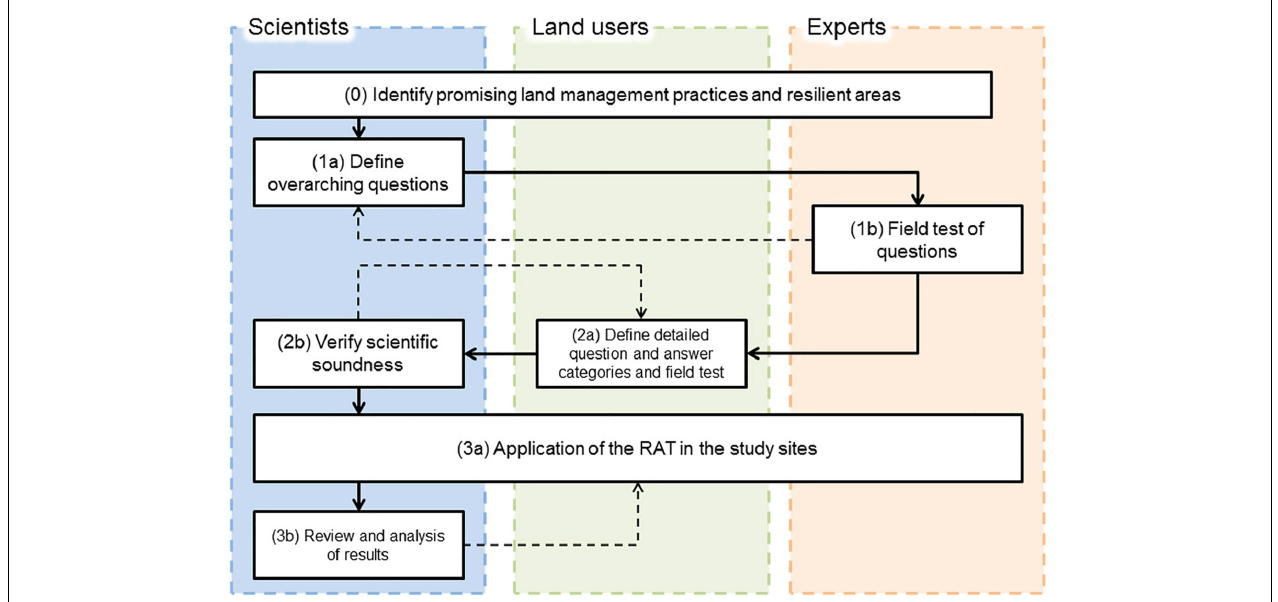
FIGURE 7 | Development and application of the Resilience Assessment Tool (RAT) within this research and interaction with different stakeholder groups. “Experts” refer to local experts or land management advisors; “land users” includes land owners, shepherds, and forest workers. Adapted from Jucker Riva et al.